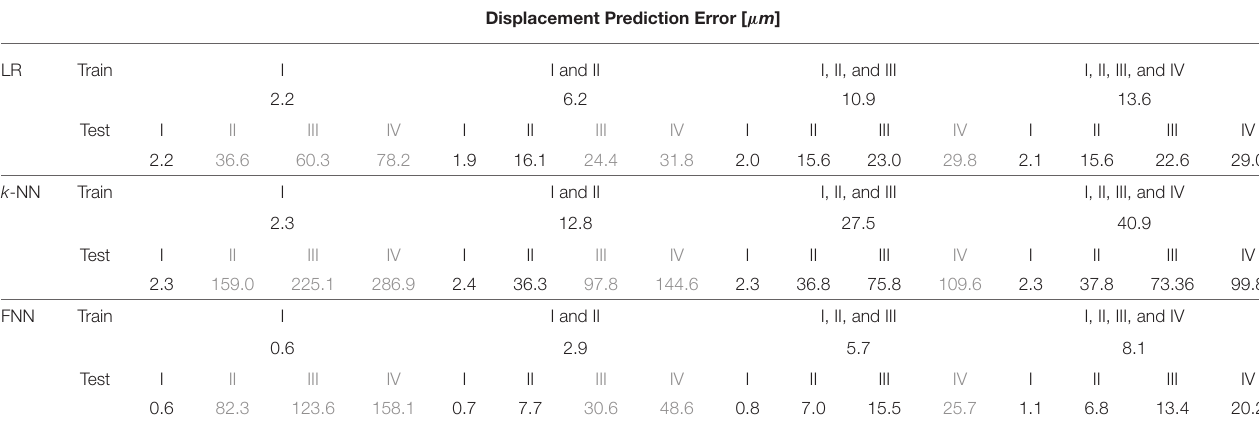
TABLE 1 | Reconstruction task: comparison of multi-contact prediction methods and dataset for predicting the displacements D from simulated sensors S .